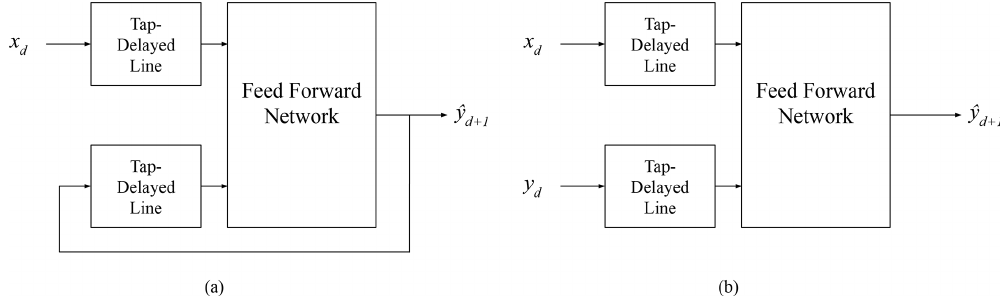
Figure 4. Different architectures of a NARX model: (a) parallel architecture and (b) series-parallel